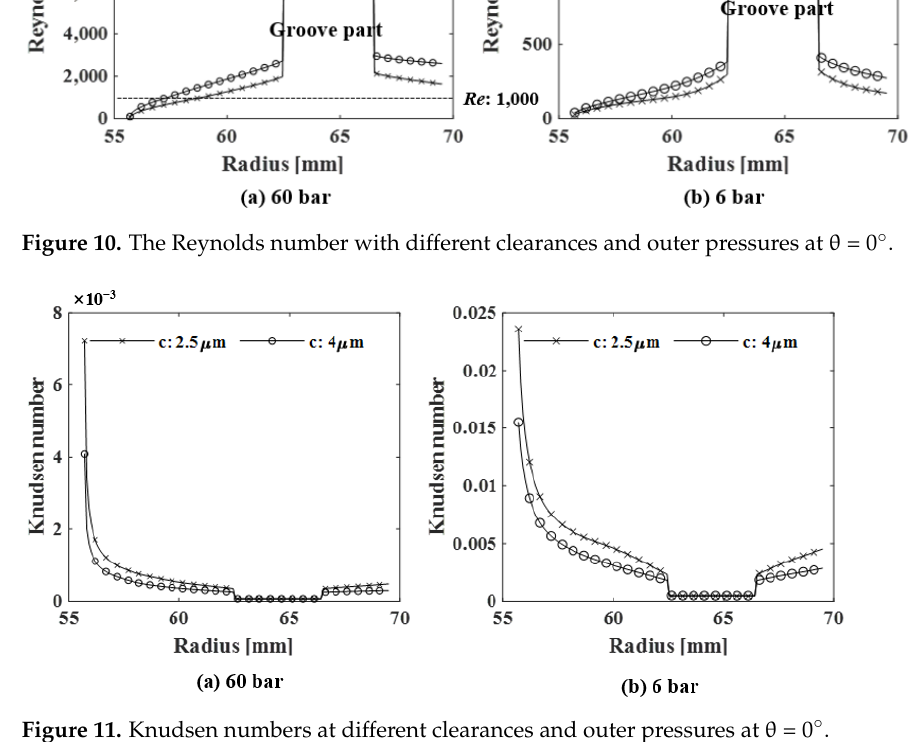
Figure 11. Knudsen numbers at different clearances and outer pressures at θ = 0°.